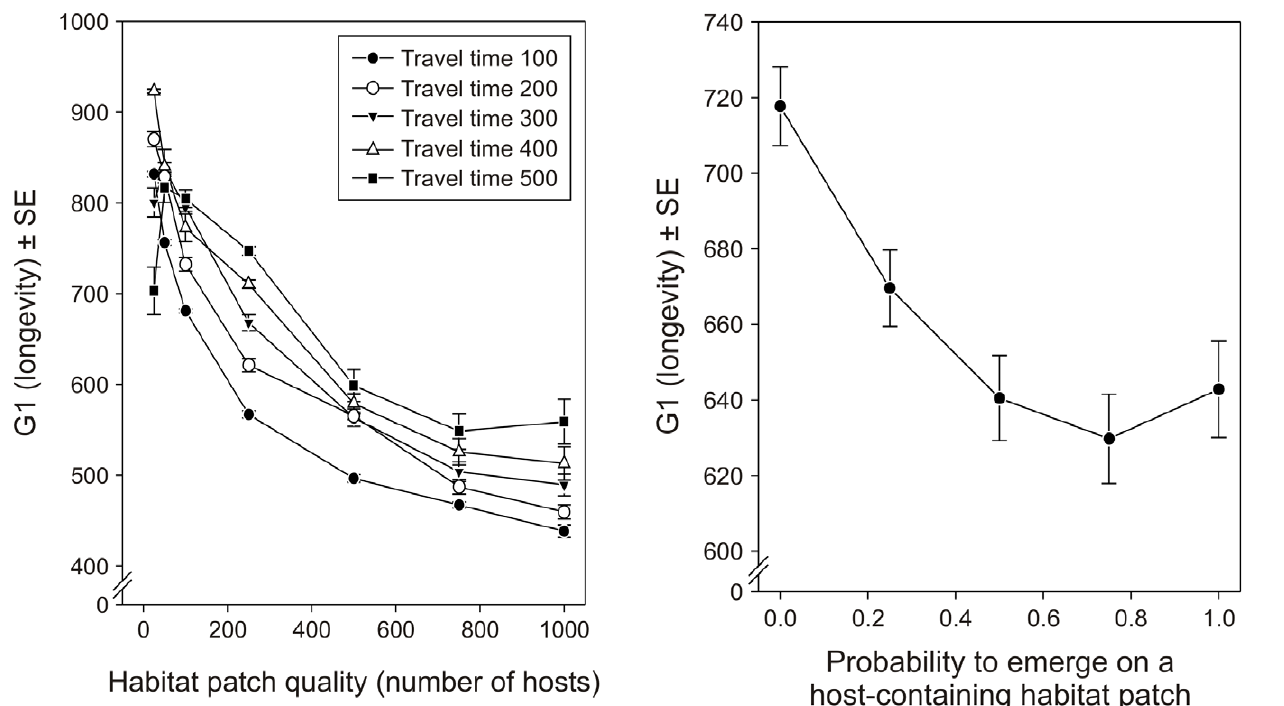
Figure 3. Effect of the probability for a parasitoid female to emerge on a host-containing habitat patch on the optimized values of the parameter G1. Average ( 6 SE) optimized values for the parameter G1 defining the initial reproductive strategy on the trade-off between longevity and egg load (see Figure 1) for different probabilities for the parasitoid females to start their life on a habitat patch.